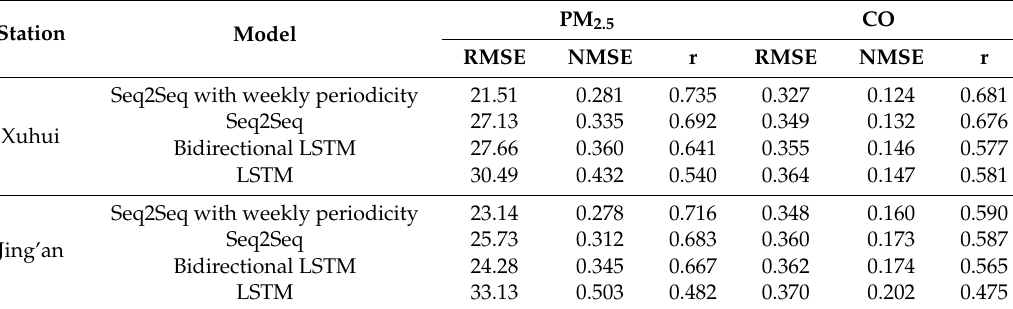
Table 1. Comparison of the forecasting model